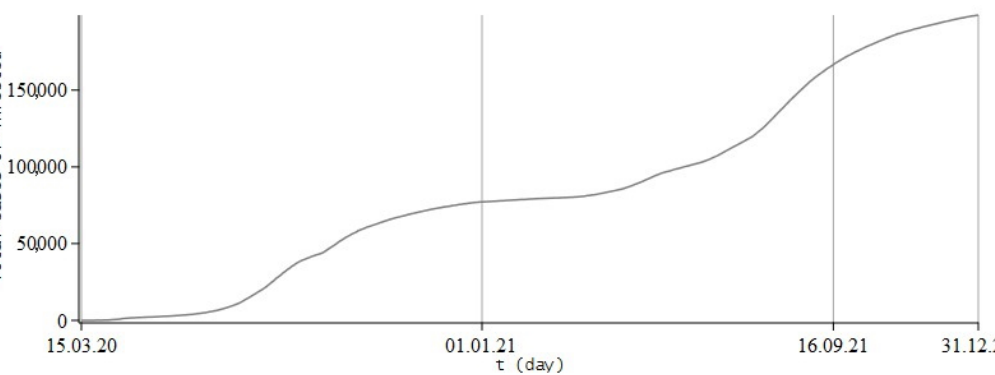
Figure 15. Experimental data: for total cases of COVID-19 infection in the Republic of Uzbekistan, from 15 March 2020 to 31 December 2021, with a step of 1